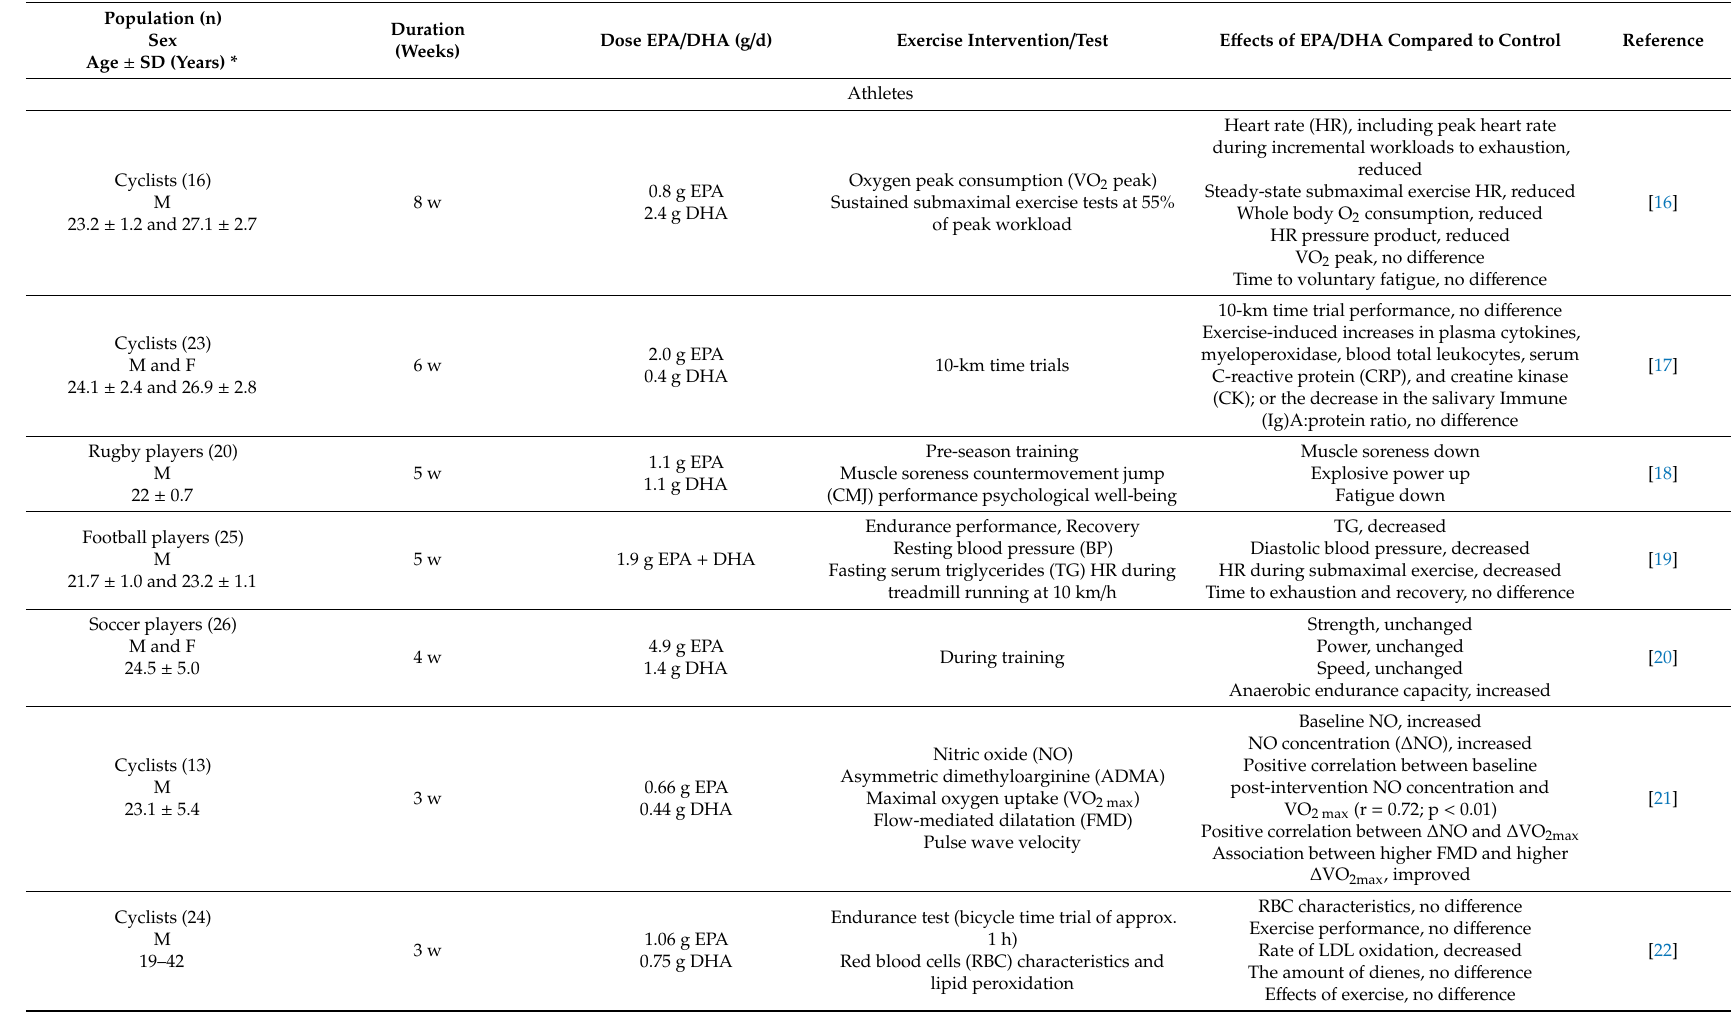
Table 1. E ff ects of EPA / DHA supplementation with a focus on performance-related outcomes in athletes and